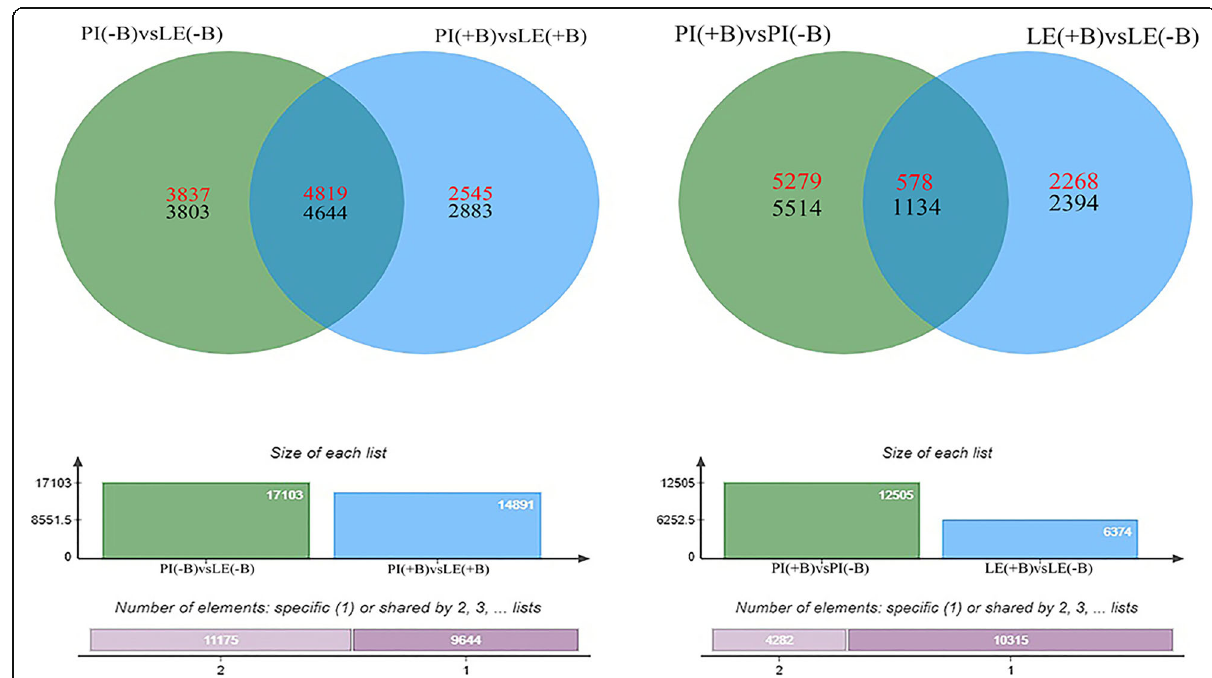
Fig. 3 Common and specific DEGs in the two rice cultivars after induction treatment by barnyard grass root exudates. Note: upregulated DEGs are in red, and downregulated genes are in black. PI(+B) and LE(+B) represent the PI and LE accessions treated with barnyard grass root exudates. PI( − B) and LE( − B) represent the corresponding no-induction